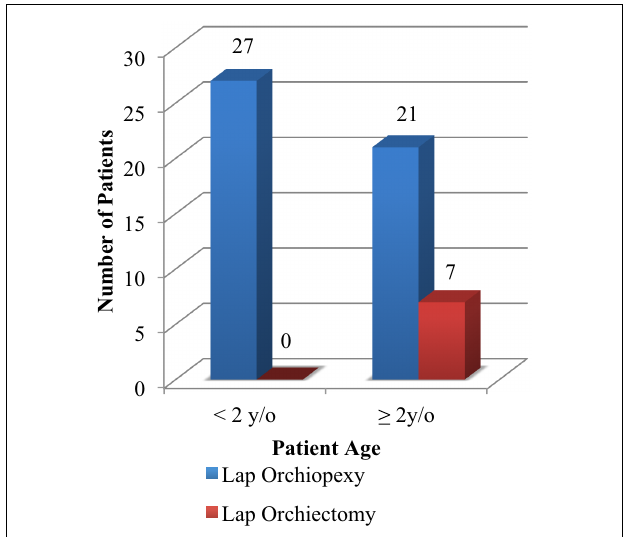
FIGURE 2 | Patient’s age versus laparoscopic intervention ( p < 0.05) .